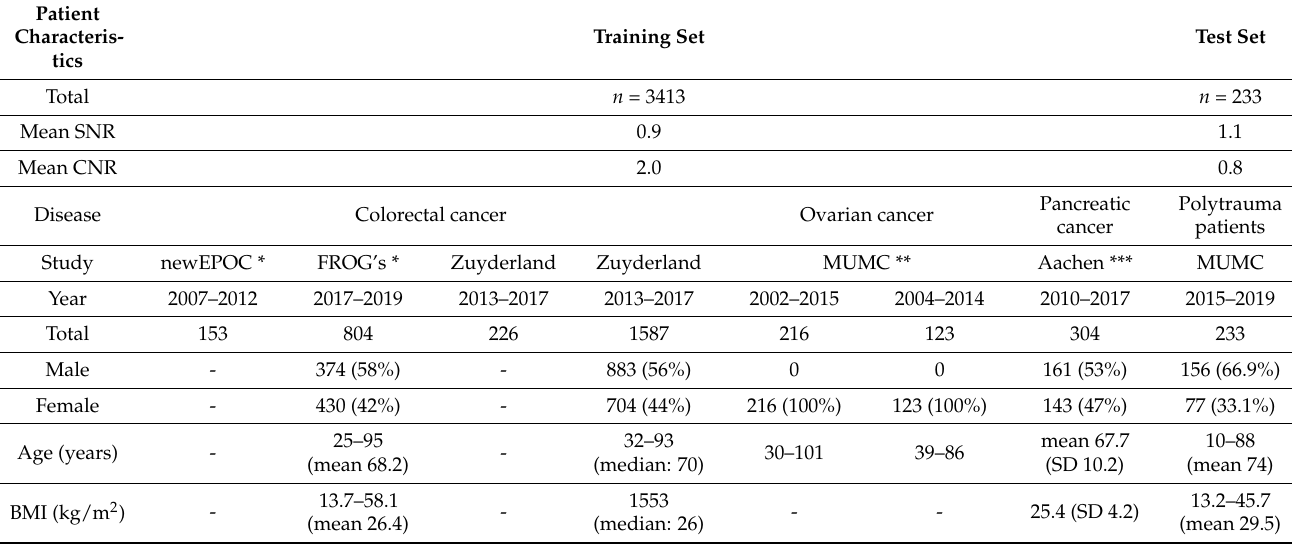
Table 1. Patient characteristics of the entire cohort ( n = 3413), training ( n = 2730, 80%), validation set ( n = 683, 20%) and the test subset (n =